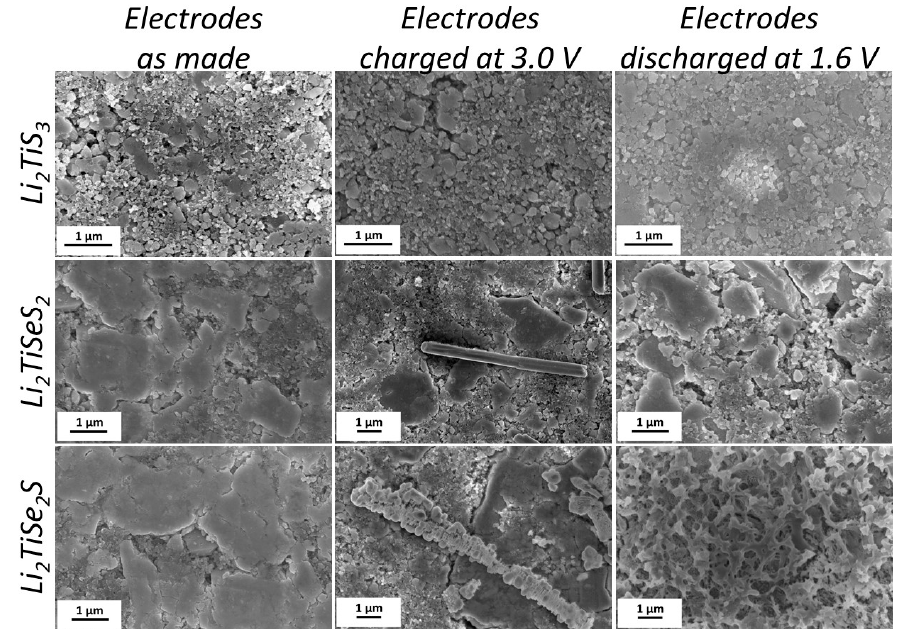
Figure 8. SEM images of Li 2 TiS 3 , Li 2 TiSeS 2 , and Li 2 TiSe 2 S electrodes at different states of charge: pristine, at the end of charge (3 V) and at the end of discharge (1.6 V).